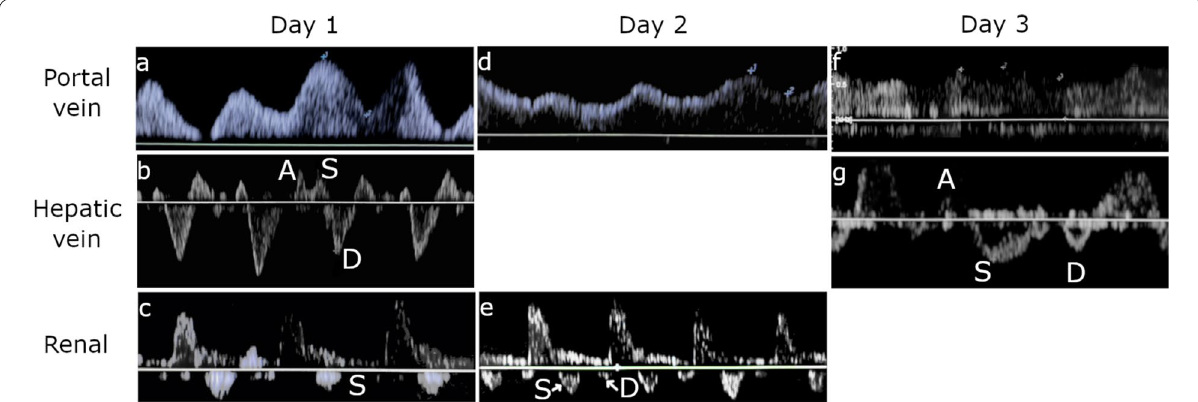
Fig. 4 Case 3: Doppler profiles of portal vein, hepatic vein, and intrarenal vasculature at days 1, 2 and